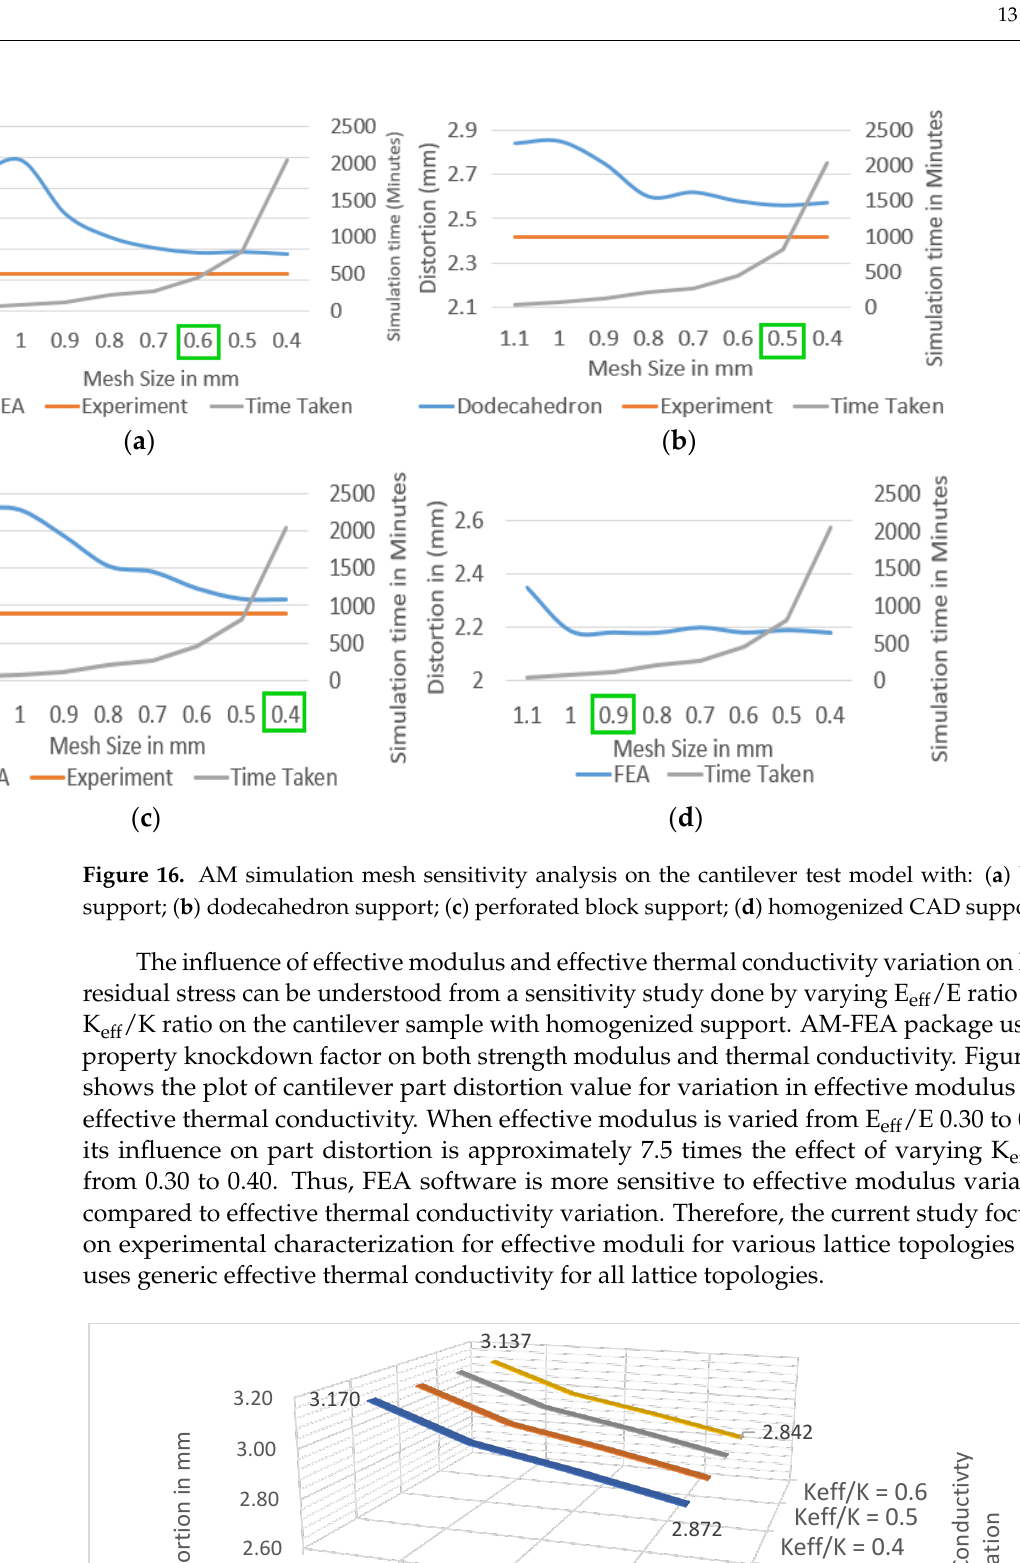
5.25 Figure 15. Cantilever part distortion comparison—Experimental versus Simulation results. FE simulation results comparison shows that the average deviation of homogenized support simulation is approximately 5% compared to actual support simulation of roughly 3%. The use of true support geometry simulation is not consistent. Its under-pre- dicted distortion in the octahedron support and high distortion in BCCZ. On the other hand, the homogenization model is consistent in capturing the behavior of all different lattice topologies. The experimental result and FE simulation error percentage are approx- imately constant for all topologies except BCCZ support. Thus, loading effective property from characterization will eliminate any variation caused by process variation and pro- vide a consistent result for any selected lattice topology. BCCZ is not isometric in lattice topology. Assuming it as isometric in homogenization has led to the error in the proposed method. The FE simulation speed comparison between actual geometry and homogenized model can be observed from the mesh sensitivity analysis study presented in Figure 16. Homogenized solid block with single continuum geometry saturates below 0.9 mm mesh.